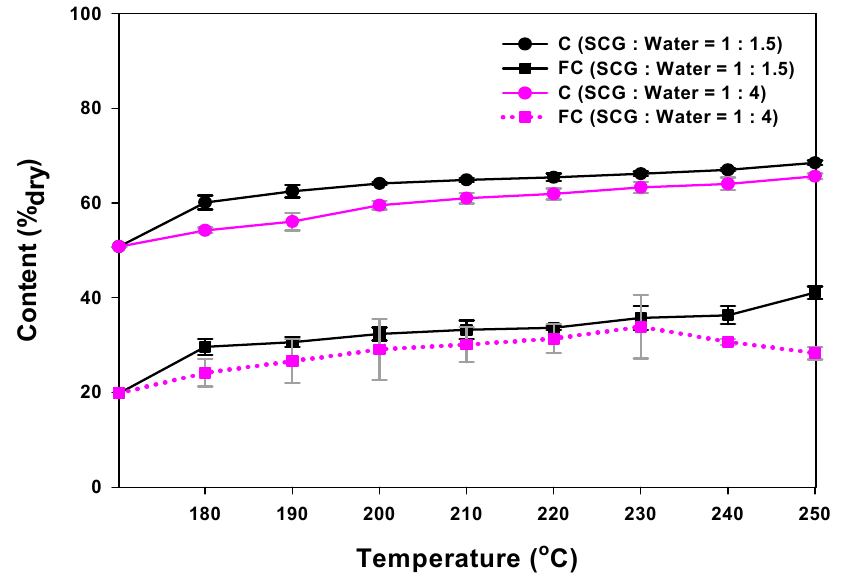
Figure 5. Amount of carbon and fixed carbon compounds in SCGs produced with different reaction temperatures and water contents. Table 2. Elemental and proximate analysis of SCGs hydrothermally carbonized with different reaction temperatures (SGC: water =